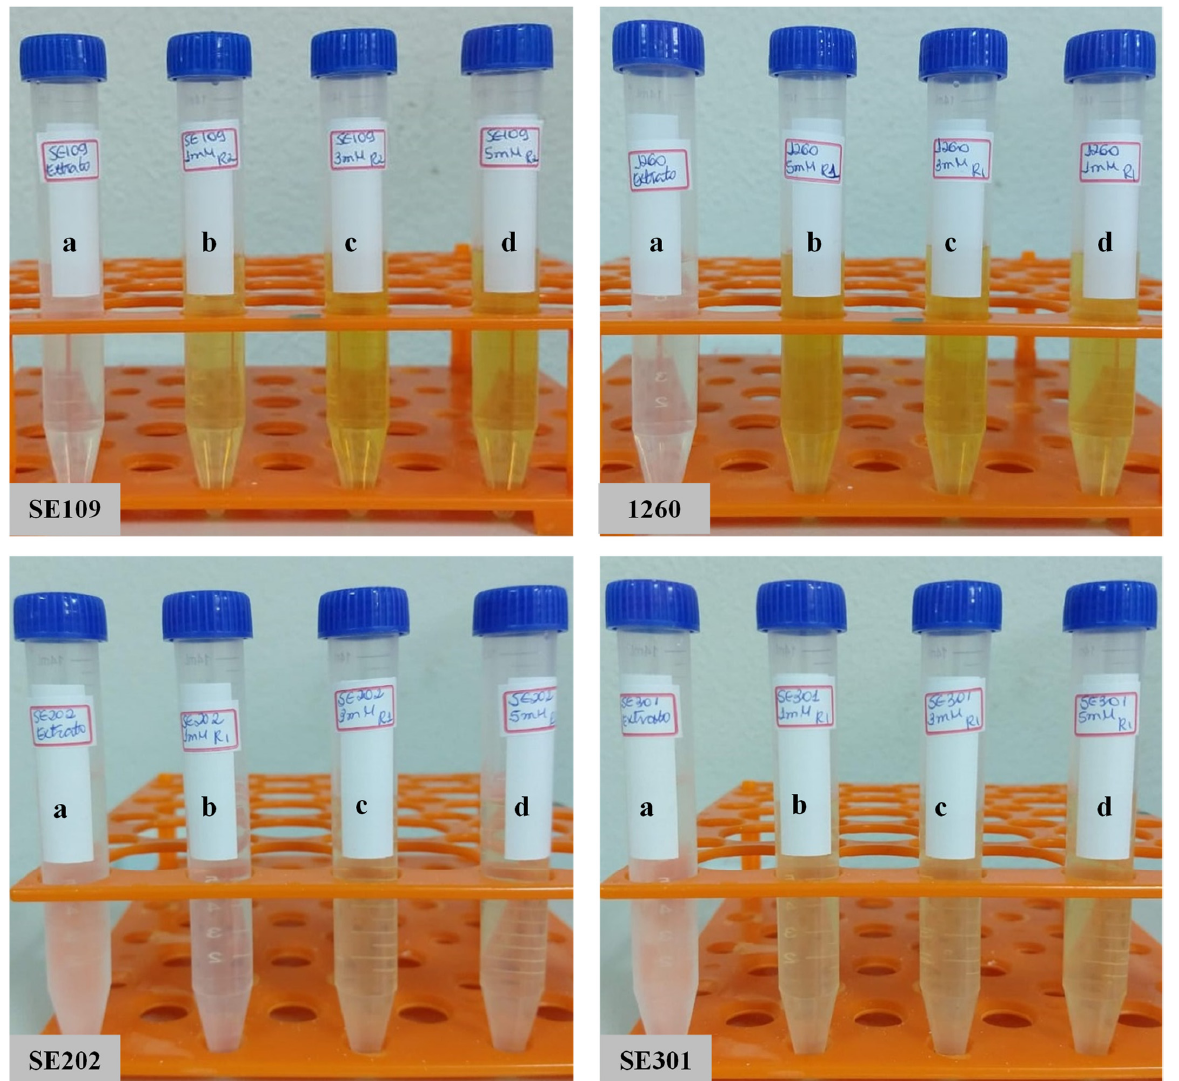
Figure 2. Synthesis reaction of silver nanoparticles with aqueous extract of entomopathogenic fungi isolates and variation in silver nitrate concentration. SE109 e 1260 ( B. bassiana ), SE202 ( M. anisopliae ) and SE301 ( I. fumosorosea ). (a) Pure extract, (b) AgNO 3 1 mM, (c) AgNO 3 3 mM, (d) AgNO 3 5 mM.